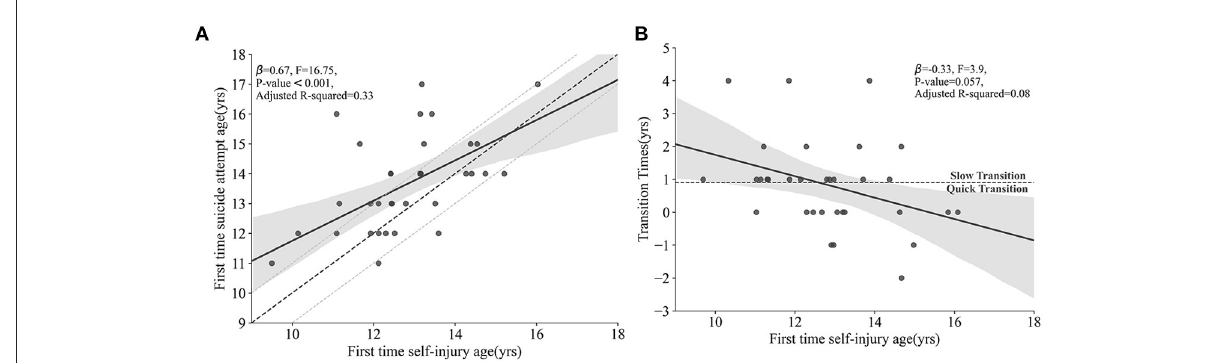
FIGURE1 (A) The association between the onset age of NSSI and SA. The solid black line slowly approaches the diagonal dashed line in the figure, which is the line that fits the appearing NSSI and SA at the same age. (B) The association between the transition time from NSSI to SA and the onset age of NSSI. The area below the dashed line indicates the “Quick Transition” mode (time required from the onset of NSSI to SA was < 1 year); the area above the dashed line indicates “Slow Transition” mode (time required from the onset of NSSI to SA is ≥ 1 year). NSSI, non-suicidal self-injury; SA, suicide attempt.